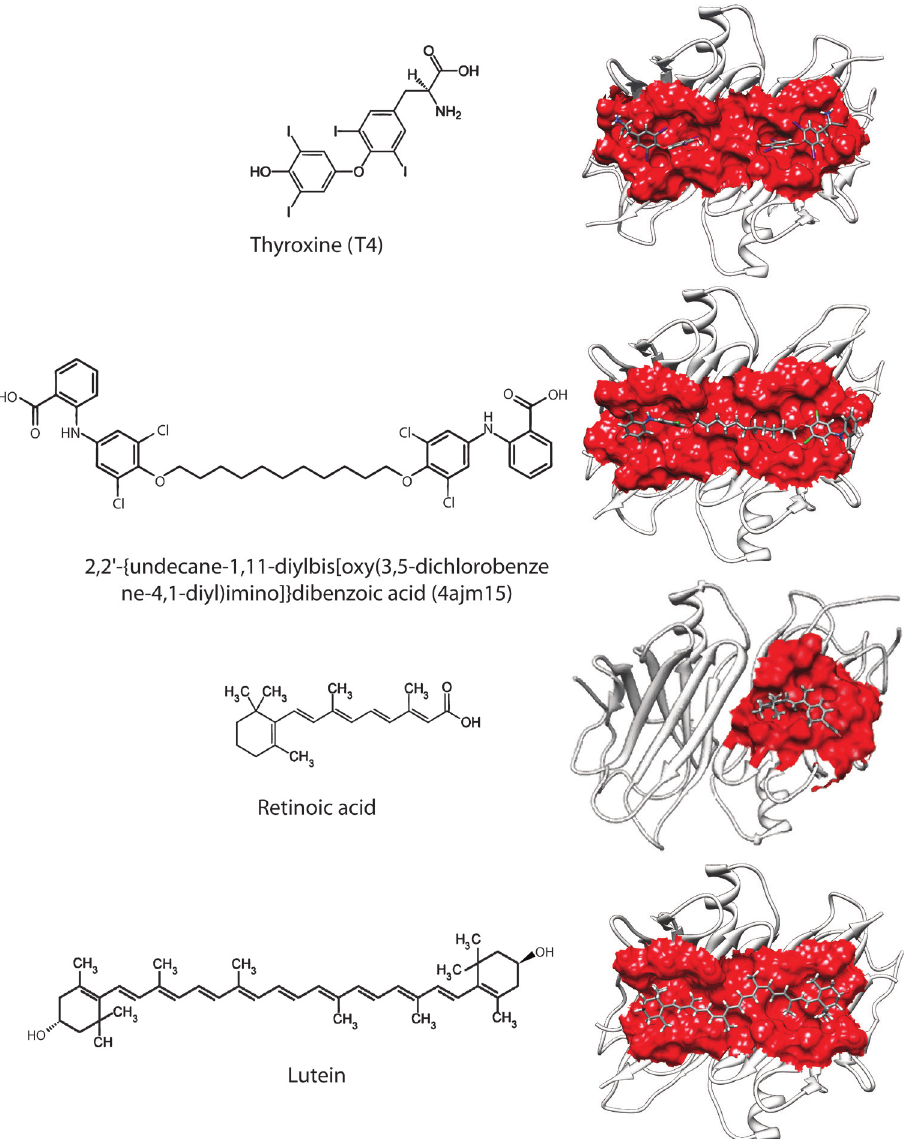
Figure 2 Experimental structures and computational models of TTR complexed with natural and engineered ligands bound to the T4 binding